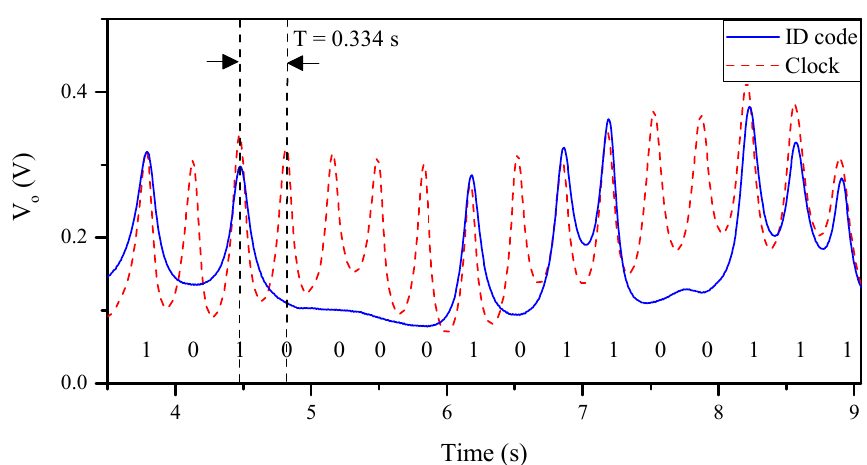
Figure 8. Measured envelope functions (ID code and clock signals) of the 16-bit encoder with the indicated code.